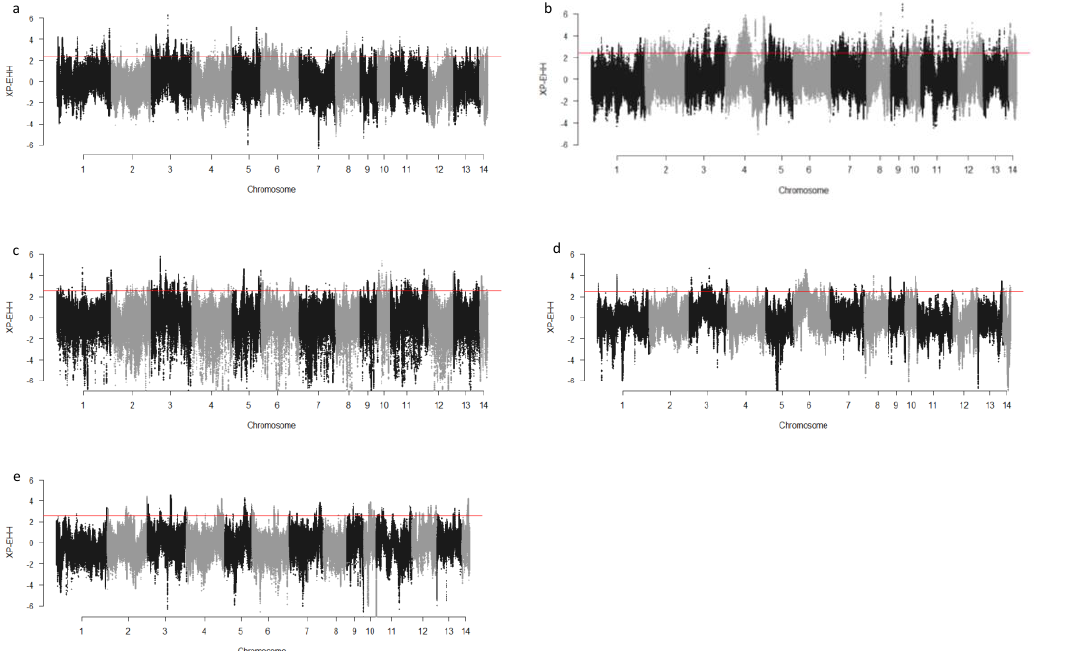
Figure 1. Genome-wide distribution of Fst across chromosomes in different groups of fur quality and coat color in American mink. The horizontal lines indicate the top 1% of values across the entire